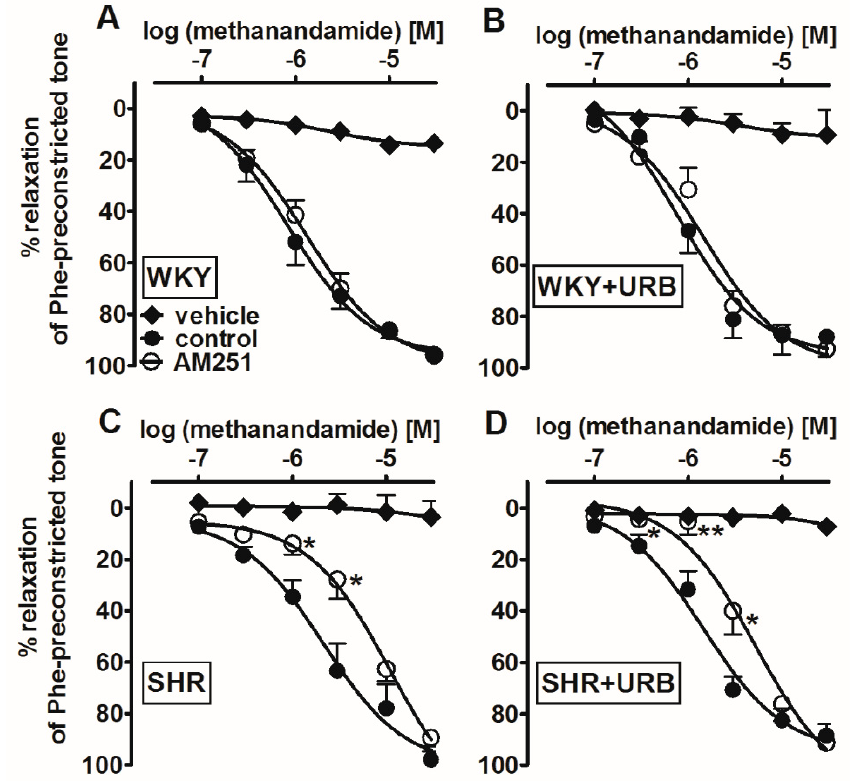
Figure 4. Influence of AM251 (1 µ M) and its vehicle on the relaxant effects of methanandamide in the mesenteric G3 arteries from normotensive control (WKY; A ) and URB597-treated (WKY + URB; B ) rats or hypertensive (SHR; C ) and URB597-treated (SHR + URB; D ) rats. URB597 at 1 mg/kg or its vehicle was injected intraperitoneally every 12 h for 14 days. The results are expressed as percentages of the relaxation of the isometric contraction induced by phenylephrine (Phe). Mean ± SEM of n = 8–10 tissues for each curve. * p < 0.05 and ** p < 0.01, compared to the * control, as determined by Student’s t -tests for unpaired data. In a few cases, the SEM is smaller than or equal to the size of the symbols. See Table 1 for statistical analysis .